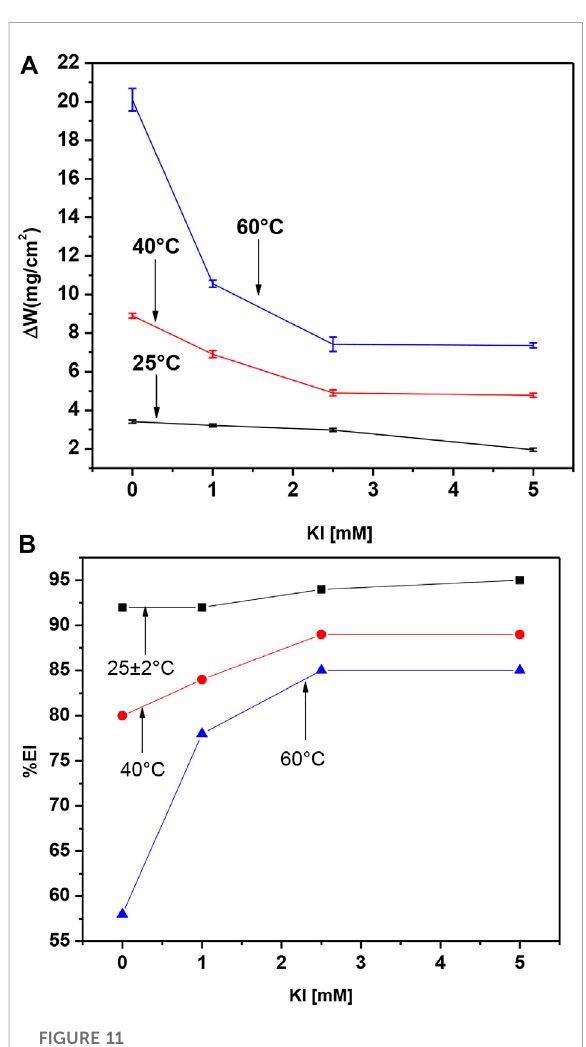
FIGURE 11 Effect ofKI concentration andtemperatureon (A) weight loss and (B) inhibition ef fi ciency for 1018 steel in acid media with 500 ppm of M.